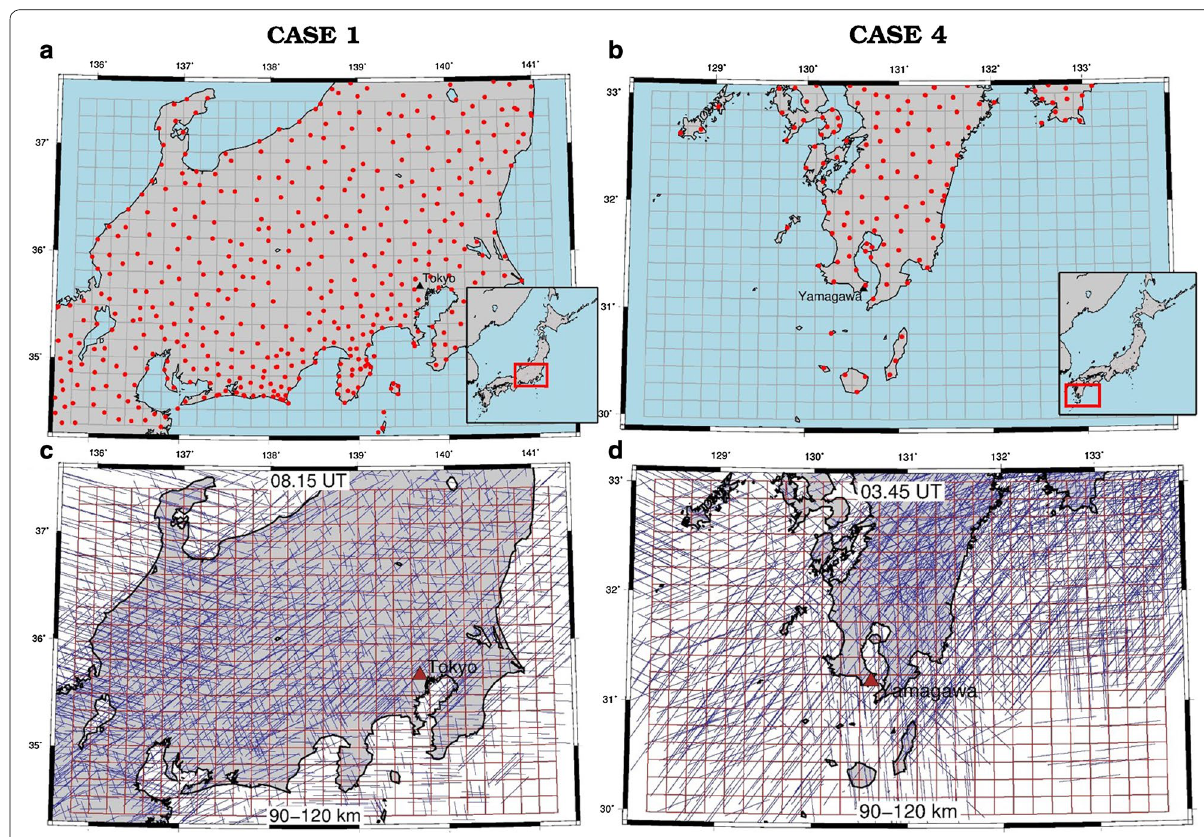
Fig. 1 Maps showing the distribution of GNSS stations (red dots) and the blocks above the Kanto ( a ) and the Kyushu ( b ) Districts, Japan. Blocks extend upwards covering altitudes from 60 to 270 km above the surface. The distribution of LoS penetrating blocks at the altitude of 90–120 km of the satellite–station pairs used for 3D tomography for Case 1 above Kanto ( c ) and Case 4 above Kyushu ( d